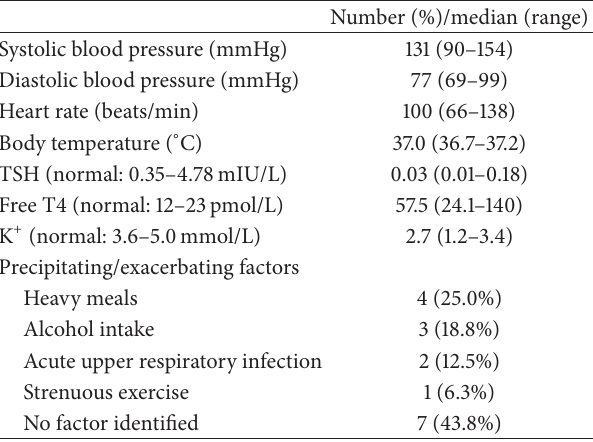
Table 2: Clinical and biochemical profiles of the 16 patients on the presentation of